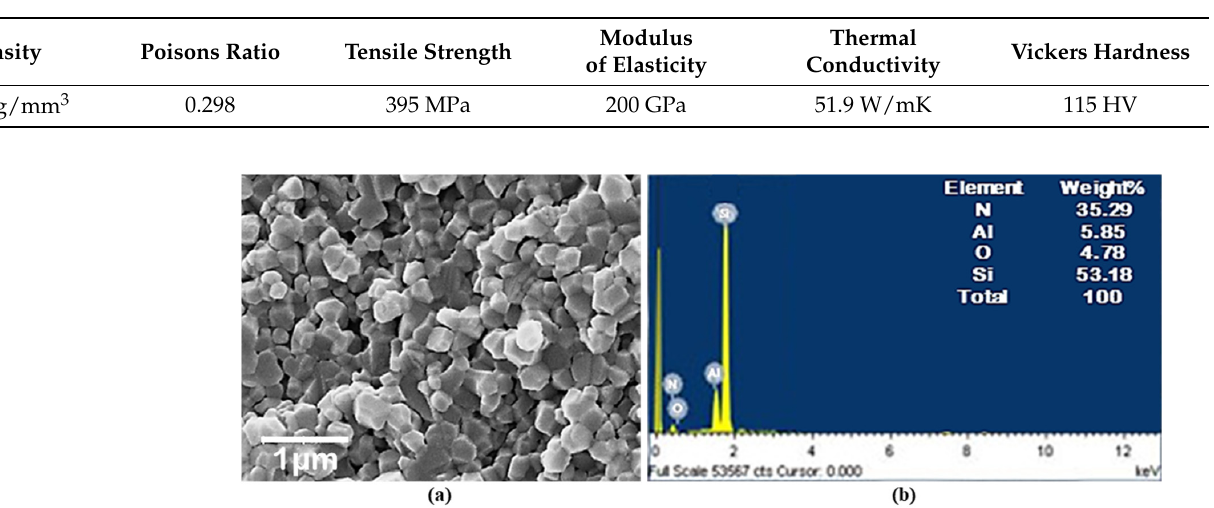
Figure 2. ( a ) Microscopic analysis through SEM and ( b ) EDX ray spectroscopic analysis of SiAlON ceramic tool [34] .